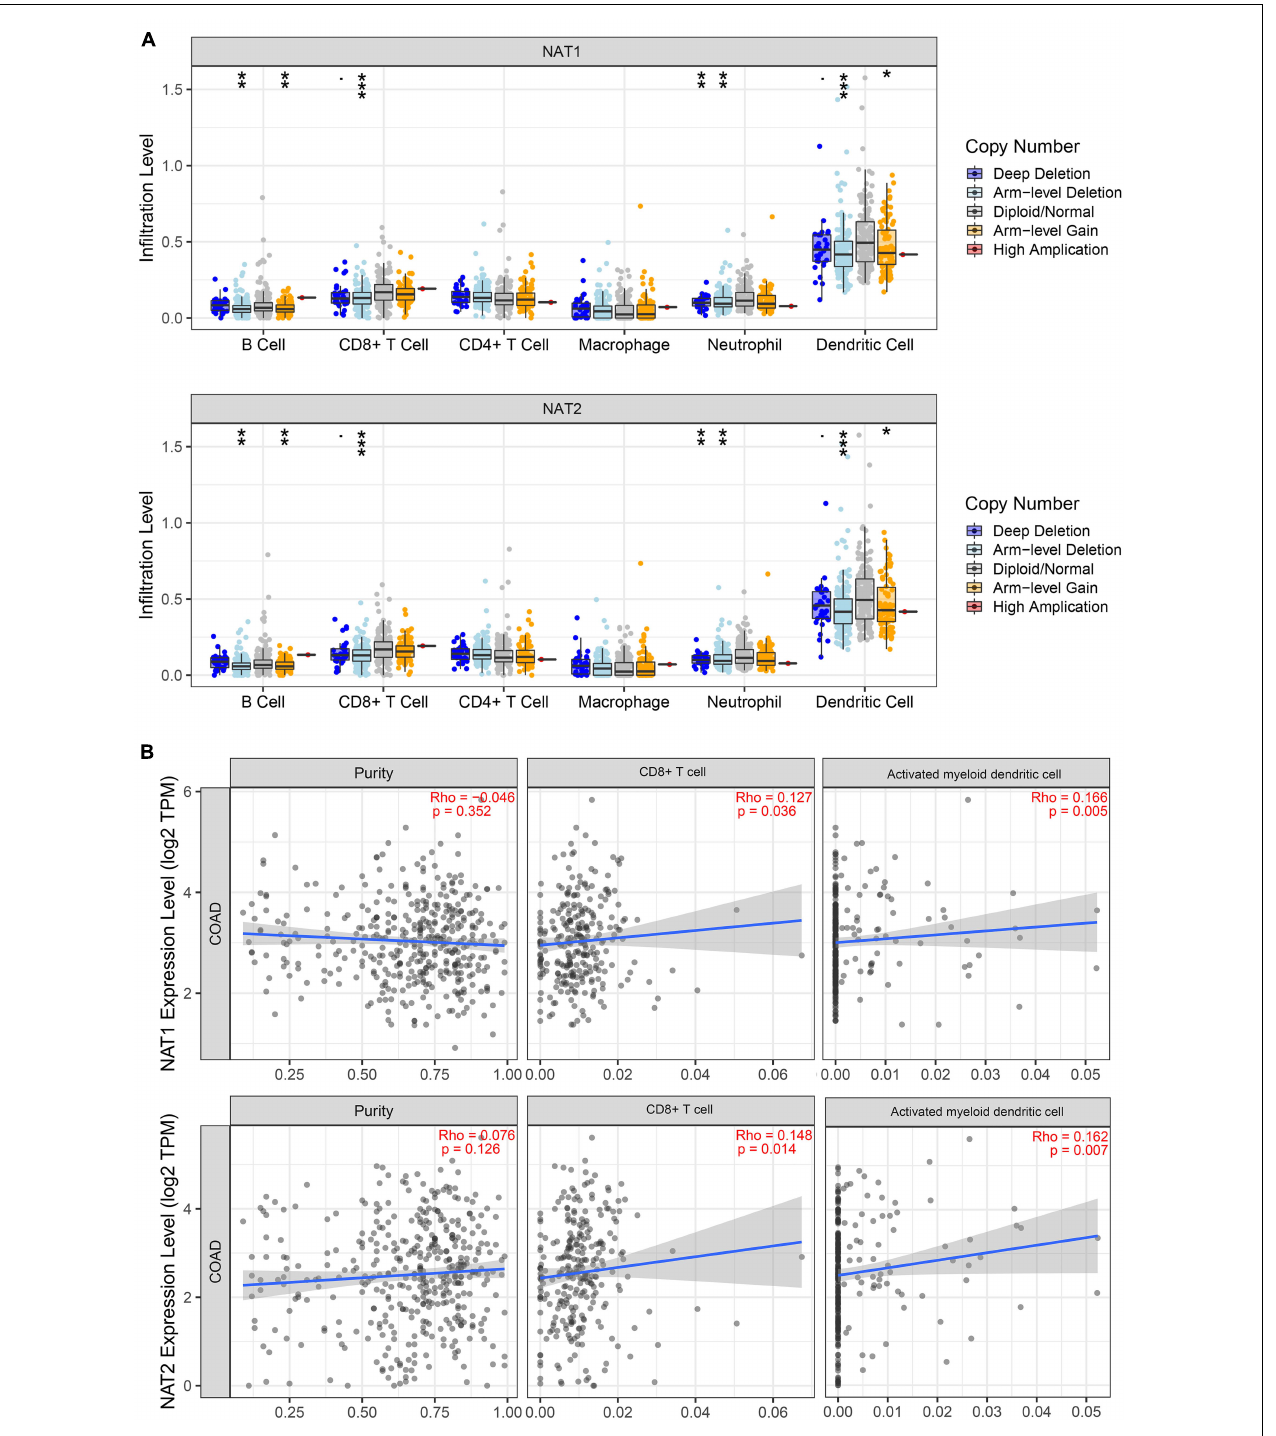
FIGURE 11 | TIMER analyses of NAT1 and NAT2 . (A) The associations of somatic copy number alterations (SCNAs) of NAT1 and NAT2 with immune infiltrates in COAD. The SCNAs in TIMER included deep deletions, arm-level deletions, diploid/normal alterations, arm-level gains and high amplifications. The SCNA categories of NAT1 and NAT2 were presented at the right bottom and the distributions of each immune cell subset at each mutation status were plotted by box plots. Two-sided Wilcoxon rank sum test with calculated p -value was utilized to compare the immune infiltration level in each category with that for normal samples. * P < 0.05; ** P < 0.01; *** P < 0.001. (B) Correlation of NAT1 and NAT2 expression levels with tumor purity and infiltrating levels of CD8+ T cells and activated myeloid dendritic cells. The Spearman method was used to determine the correlation coefficient. NAT1 and NAT2 expression levels were plotted on the y -axis, while the abundance of immune infiltrating cells was plotted on the x -axis. Gene expression levels against tumor purity was displayed on the left-most panel.